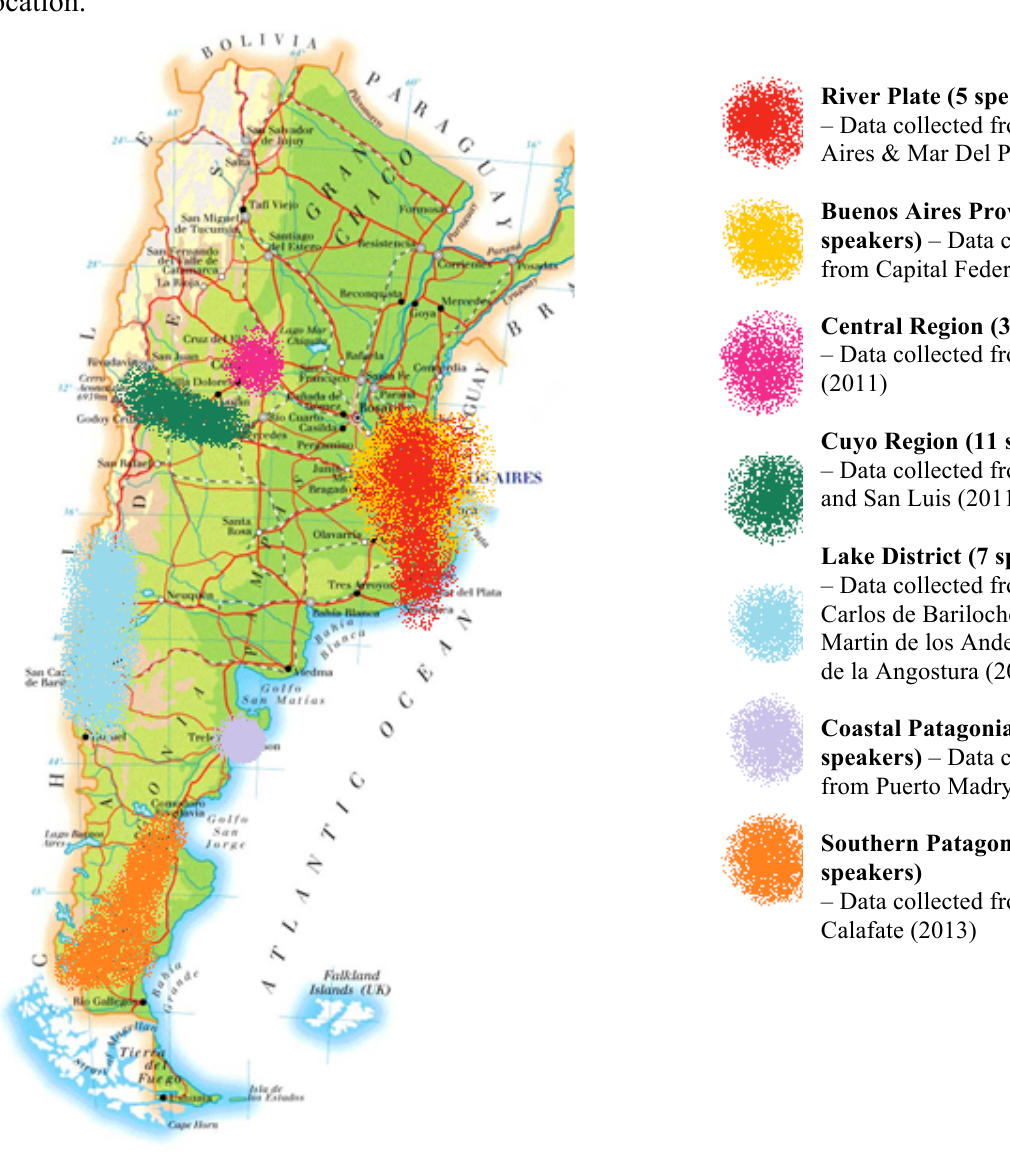
Figure 2 . Map of data collection in Argentina. Image taken from http://en.18dao.net/Map/Argentina and